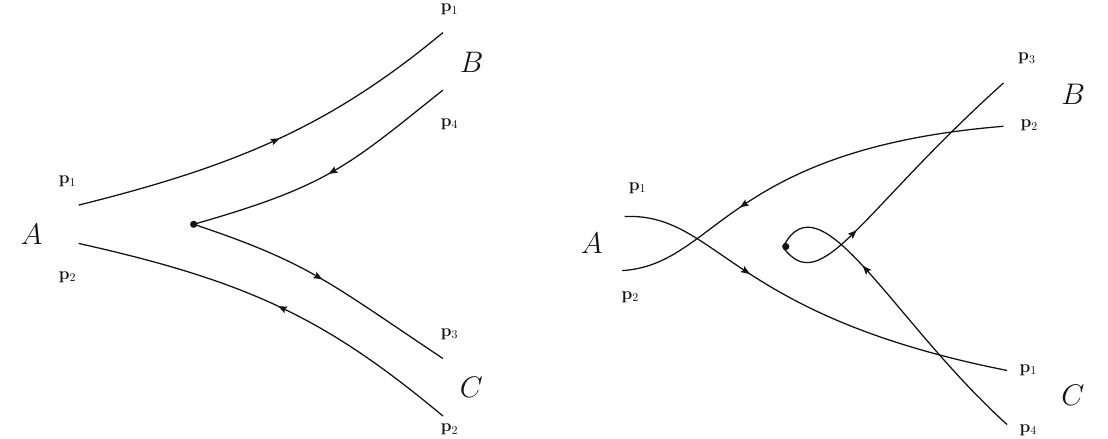
Fig. 1 Two kinds of diagrams which could happen in the quark pair creation model. The arrows on the quark lines only represent the directions of fermion lines. Usually only one of the diagrams will contribute to the amplitude, but both of them will have contributions for the f 0 meson discussed here † ( p 3 − p 4 ) is the solid harmonics. b † the vacuum. Y m m 3 and d m 4 1 2 are the creation operators of the quark and the